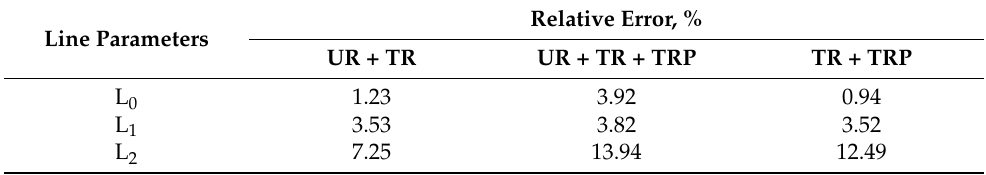
Table 5. The 5th current harmonic relative error of the equivalent nonlinear load.